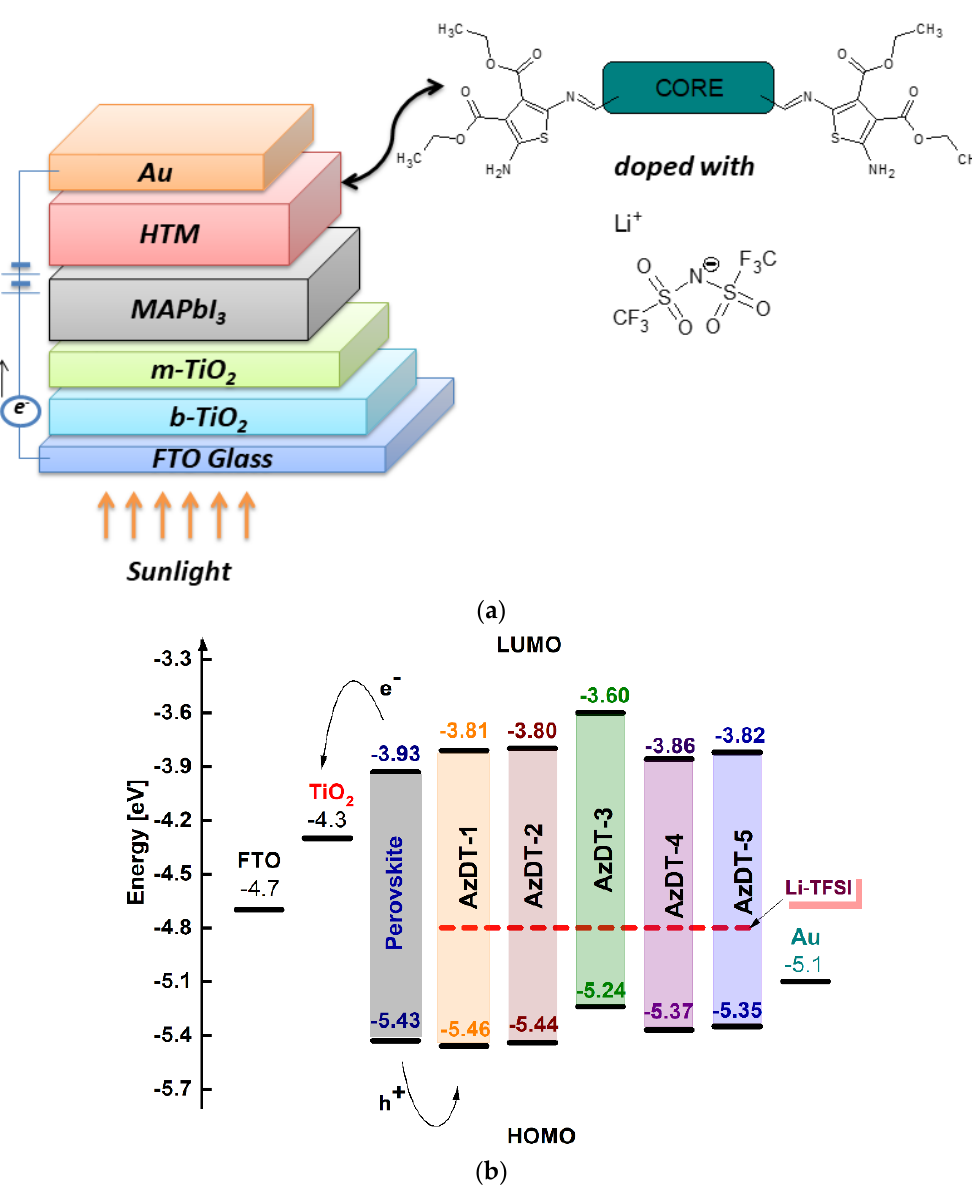
Figure 6. ( a ) The sandwich hybrid solar cell structure and ( b ) the energy level diagram of the cell components.